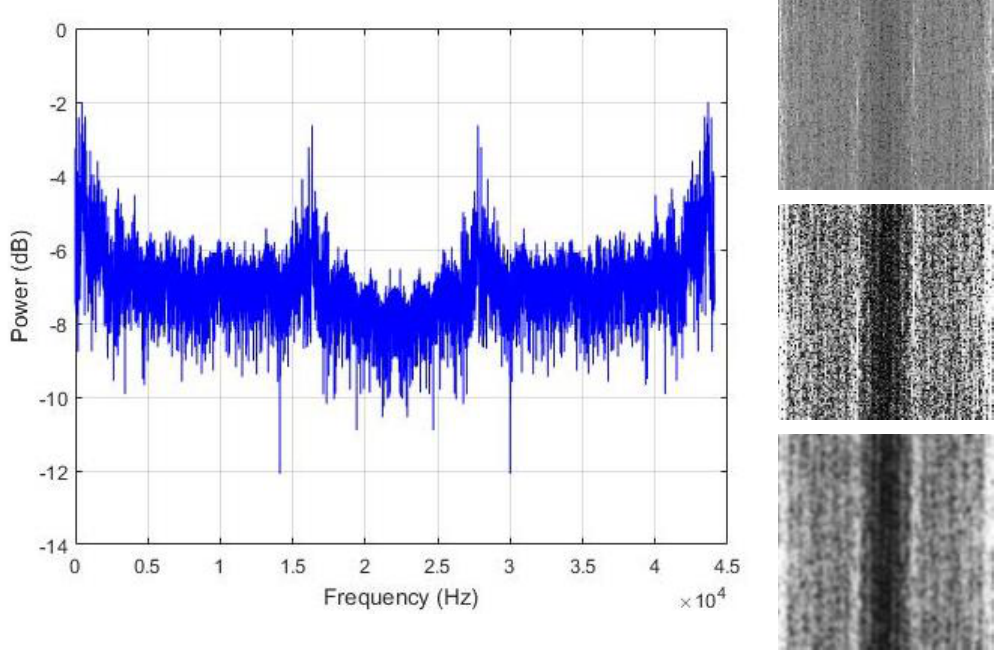
Figure 7. Left column: the power spectrum of an idle data sound; right column: the corresponding PSD-images. From top to bottom: the original image, the histogram equalized and the smoothed versions, respectively. The original size of the PSD-images shown here is 115 × 115.